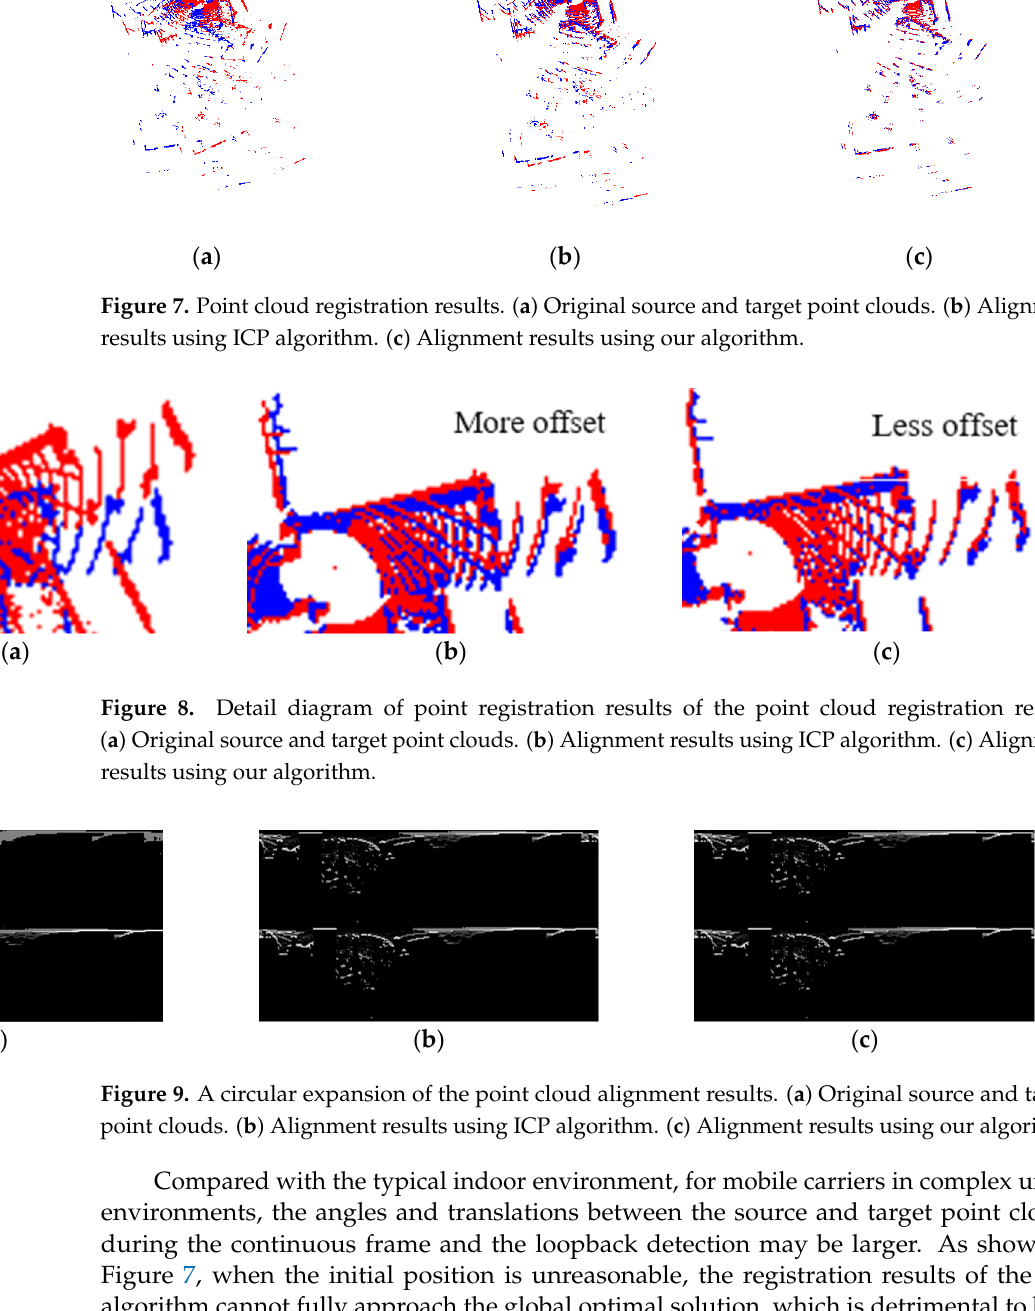
Table 2. Registration results of different algorithms for point clouds with different angles. Rotation Angles